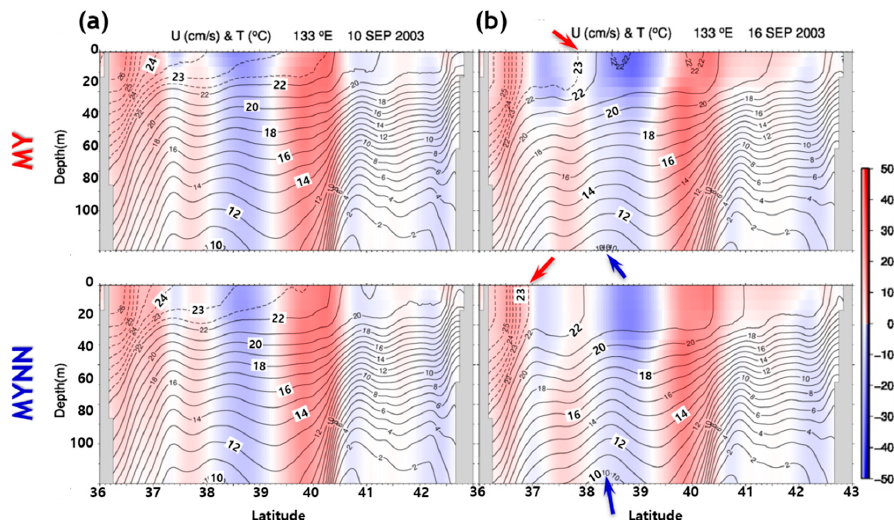
Figure 5. Vertical distribution of the temperature (contours) and zonal velocity (color-shaded) values calculated using the Mellor–Yamada (MY) (top row) and the Mellor–Yamada–Nakanishi–Niino (MYNN) (bottom row) models ( a ) before and ( b ) after Typhoon Maemi along the 133 °E line (indicated by the solid blue line in Figure 1). The red arrow indicates the southward movement of the 22.5 ˚ C isotherm in the upper layer and the blue arrow displays a rising of the 10 ˚ C isotherm to a depth of 100 m. The solid contour line interval indicates 1 ˚ C, and the dashed contour line interval indicates 0.5 ˚ C.